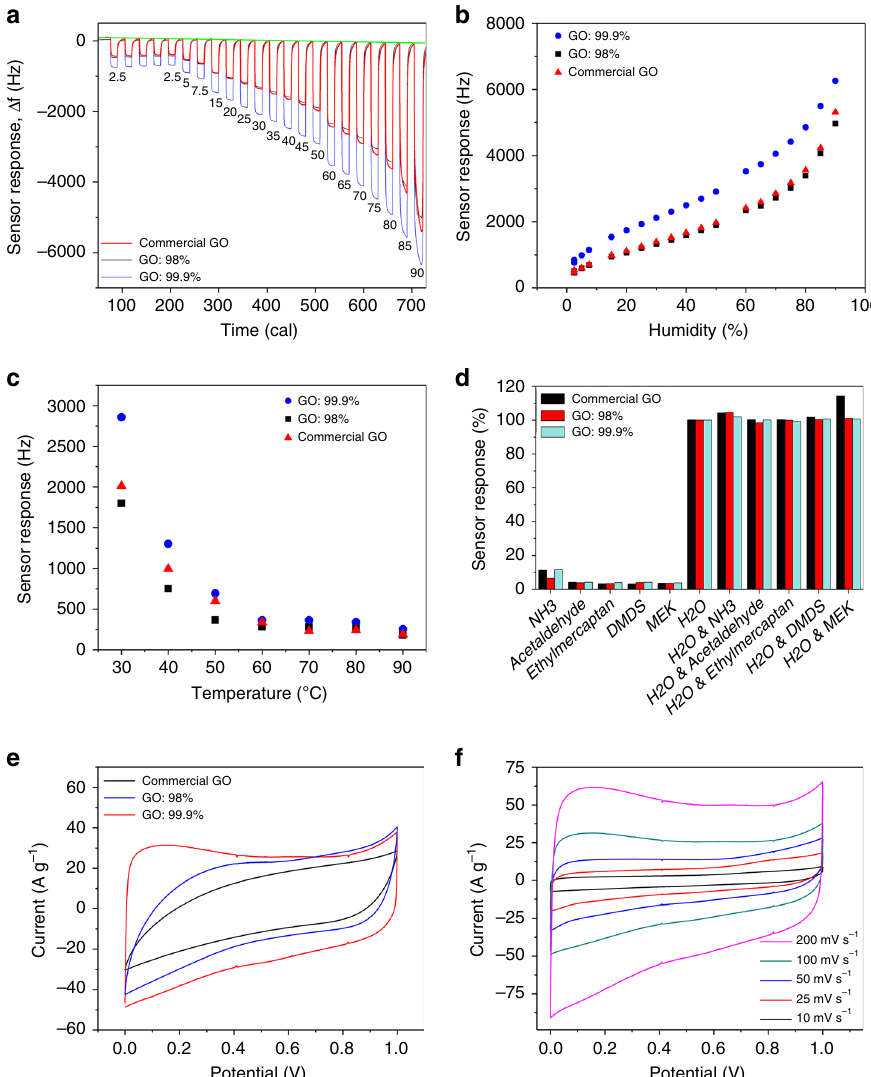
Fig. 8 The effect of silicon contamination on the device performance. a Dynamic response. The green line is the baseline absorption/desorption of a bare Ti-based QCM device. b Calibration curve of relative humidity sensors towards humidity concentrations from 2.5 to 90% RH @ 27 °C. c The effect of temperature on the sensor response as a function of GO purity (50 % RH). d Evaluation of the selectivity of the GO-based sensor (99.9% purity) following exposure to fi ve different interference gases (ammonia, acetaldehyde, ethylmercaptan, dimethyl disulphide and methylethylketone). Following the exposure to the interfering gases, there was no noticeable change in all sensor responses. e Double-layer supercapacitor performance of the reduced GO electrodes for the three different materials. The representative cyclic voltammograms (CVs) that were obtained using a two-electrode cell at 100 mV/s and using a 1 M H 2 SO 4 electrolyte; f CV of the rGO electrode made from 99.9% purity graphite as a function of scan